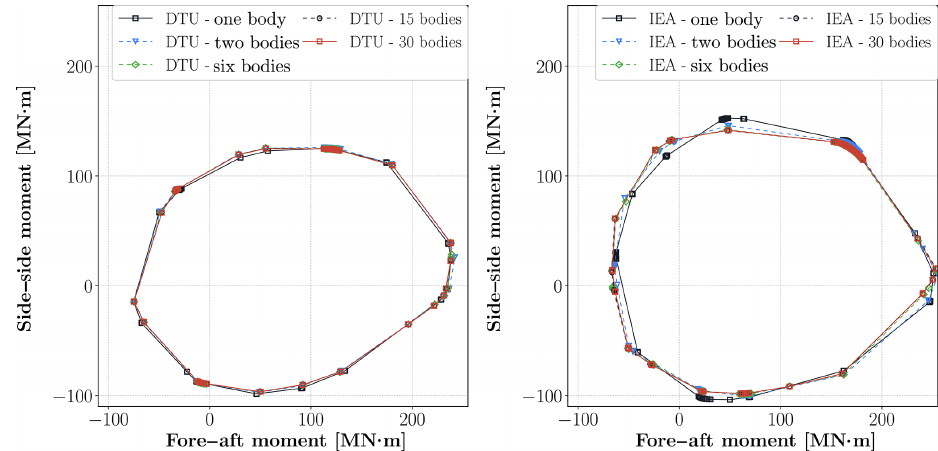
Figure 12. Tower bottom fore–aft and side–side load envelopes of the DTU and the IEA turbines for 1-, 2-, 6-, 15- and 30-sub-body